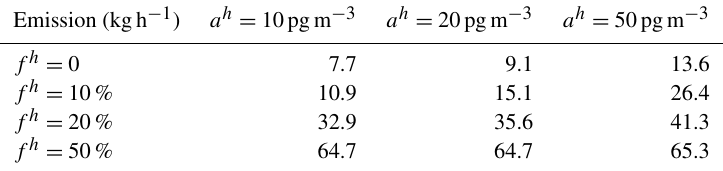
Table 6. Emission strength of release 2 that minimizes normalized F defined in Eq. (5) for different f h and a h . Concentration is taken as the metric variable. (cid:15) 2 = (f o × c o + a o ) 2 + (f h × c h + a h ) 2 . f o = 20%, a o = 20pgm − 3 .